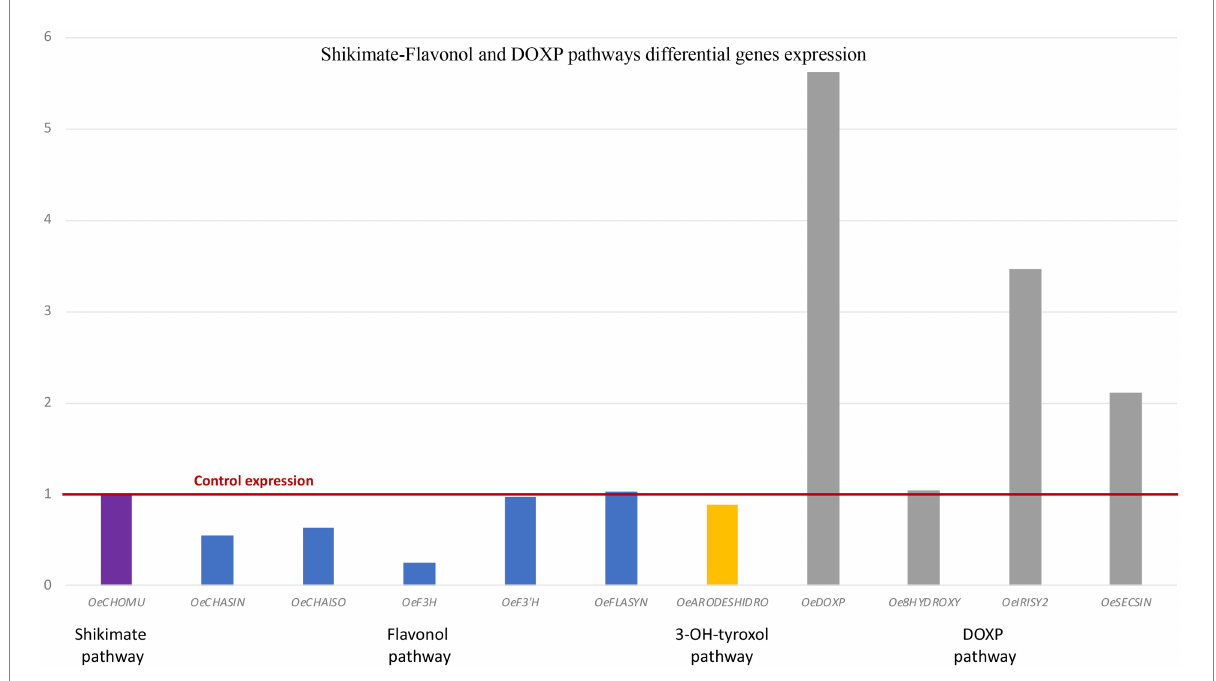
FIGURE 6 Differential gene expression of genes in the Shikimate-flavonol and DOXP pathways by RT-qPCR. Shikimate pathway (purple bars): Chorismate mutase ( OeCHOMU ); flavonol pathway (blue bars): Chalcone synthase ( OeCHASIN ), Chalcone isomerase ( OeCHAISO ) Flavonol-3-hydroxylase ( OeF3H ), Flavonol-3 ′ -hydroxylase ( OeF3 ′ H ), and Flavonol synthase ( OeFLS ); 3-OH-tyroxol pathway (yellow bars): Arogenate deshidrogenase ( OeARODESHIDRO ); DOXP pathway (gray bars): 1-deoxy-D-xylulose synthase ( OeDOXP ), 8-hydroxygeraniol synthase ( Oe8HYDROXY ), Iridoid synthase ( OeIRYSY2 ), and Secologanin synthase ( OeSECSIN ).